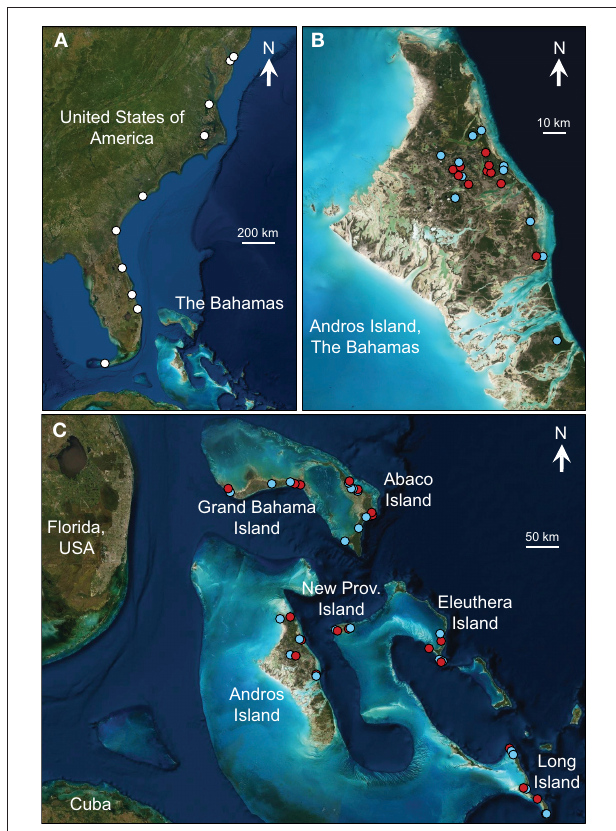
FIGURE 2 | Map of collection localities for the field studies of molluscivory in (A) Gambusia holbrooki , (B) G. hubbsi in blue holes, and (C) three species of Bahamian mosquitofish in tidal creeks. Blue symbols: high density/low predation; red symbols: low density/high predation.